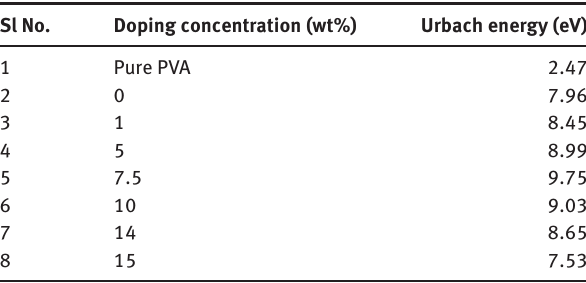
Table 2: The variation of Urbach energies of PVA doped with differ- ent doping concentration of nanoparticles.